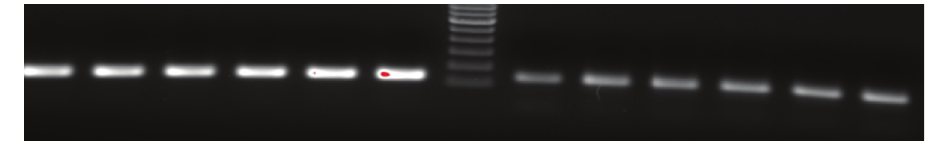
Figure 3. PD-PCR (parallel DNA PCR) and PCR: Lanes 1–6 show 120 bp PCR products amplified at annealing temperature of 45°C, 50°C, 55°C, 58°C, 60°C, 65°C, respectively, using conventional antiparallel complementary primers. Lane 7 is 100 bp molecular weight marker and Lanes 8–13 show PCR products amplified by parallel DNA PCR scheme at annealing temperature of 45°C, 50°C, 55°C, 58°C, 60°C, 65°C, respectively. In all cases, denaturation was performed at 95°C for 15 seconds, annealing for 30 seconds while extension at 72°C for 30 second for a total of 30